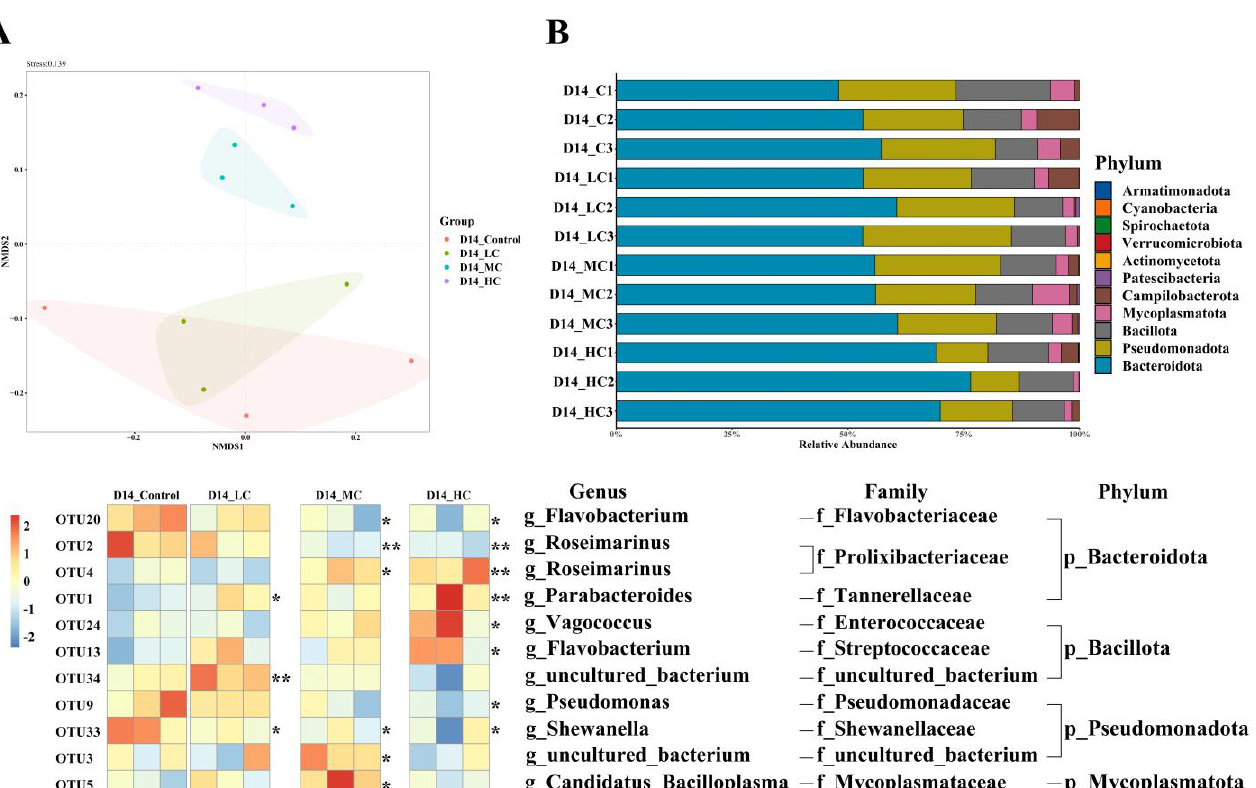
Figure 5. High concentration of FF induced significant changes in microbiota richness on day 14. ( A ) Relative abundance of bacterial at phylum level (n = 3). ( B ) NMDS based on Bray–Curtis distance matrix of OTUs. ( C ) Heatmap analysis of 11 OTUs. The color bar of each OUT in each sample is shown. The taxonomy of OTUs (genus, family and phylum) is depicted on the right. Differences were detected by one-way ANOVA. D14 denotes the samples exposed on day 14. C, LC, MC and HC denote control group, low concentration group (0.5 μg/L), median concentration group (5 μg/L), and high concentration group (50 μg/L), respectively. The asterisks “*” indicate statistical significance compared to the control group (* p < 0.05 and ** p < 0.01).